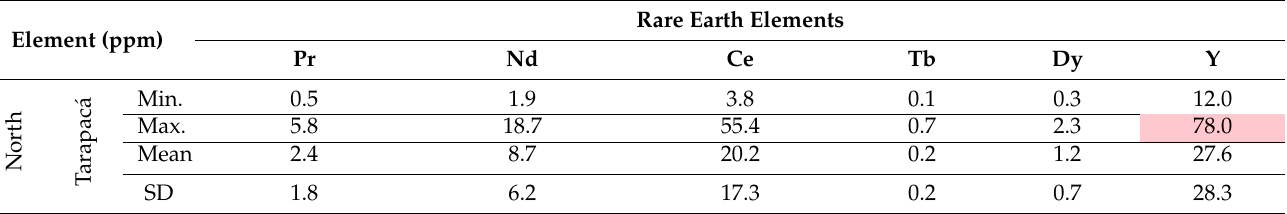
Table 4. Summary statistics of the elements classified as critical or with high economic relevance in each region from the Chilean data used in this study. Highlighted figures indicate a concentration above crustal abundance. SD: standard deviation; Min: minimum value; Max: maximum